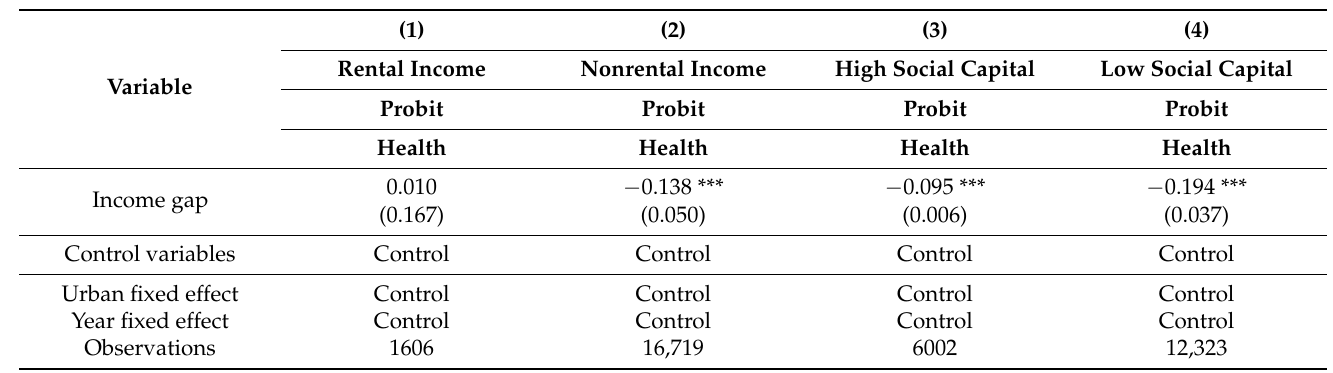
Table 12. Heterogeneity analysis results (whether there are differences between rental income and social